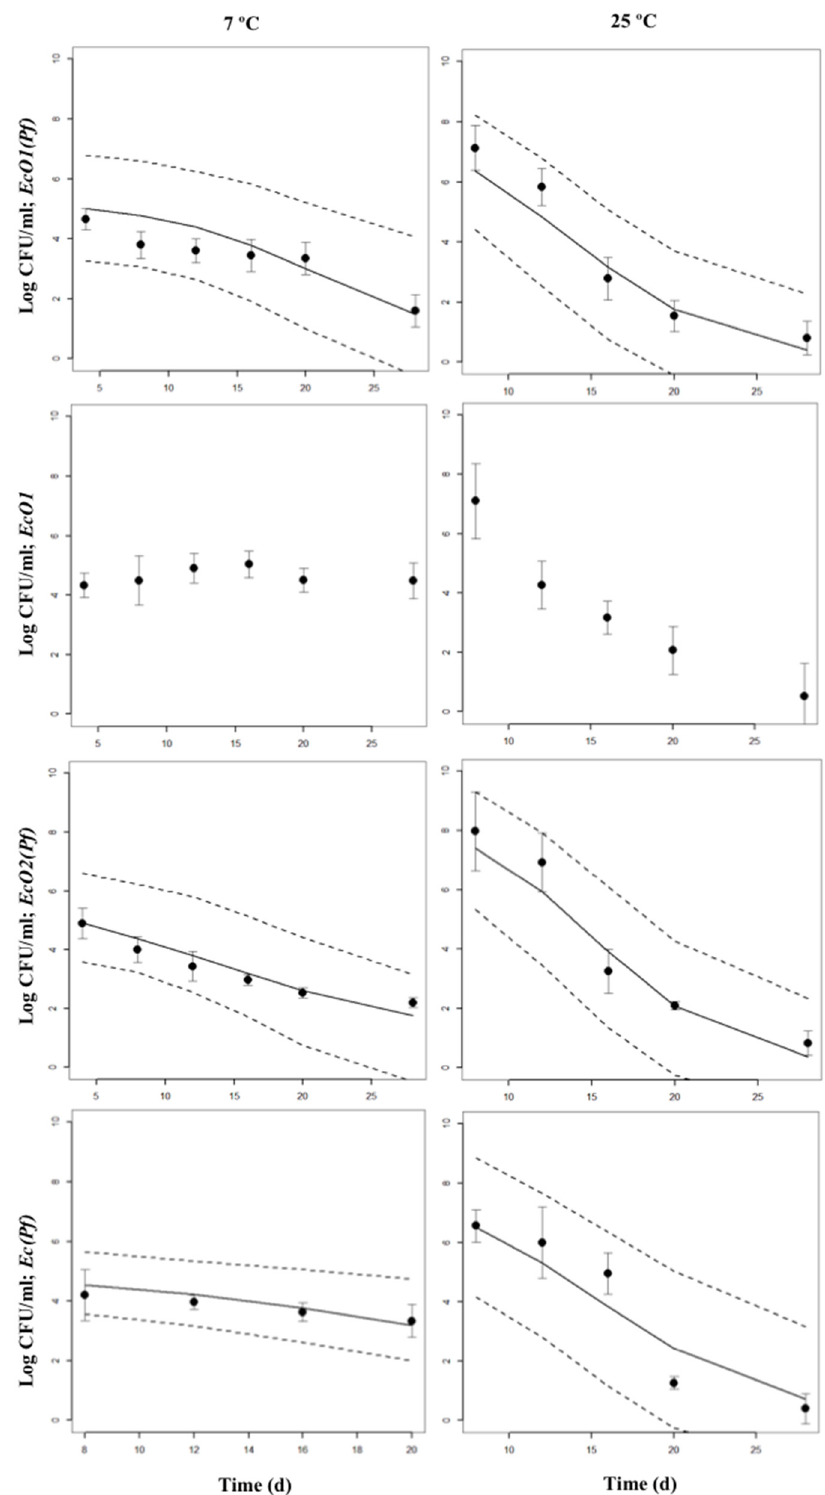
Figure 3. Bayesian inference of decline periods of co-cultures of E. coli spp. with P. fluorescens at 7 or 25 °C in skimmed milk. The 95% Highest Posterior Density intervals (2.5 and 97.5%) are shown. Points are the original data; mean and standard deviation are shown. Decline periods from EcO1 cultured alone are also shown.